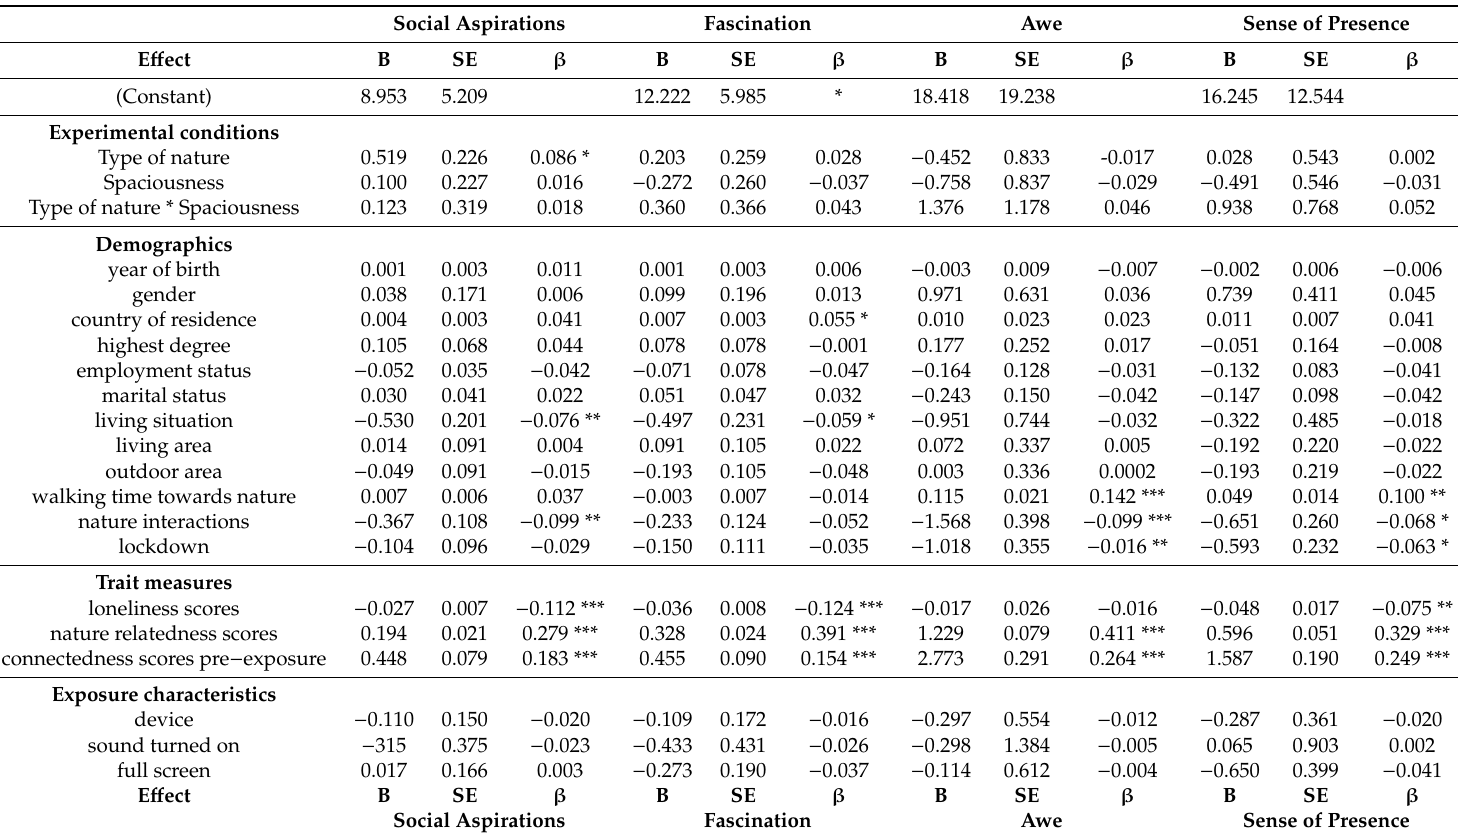
Table 2. Multiple regression models for social aspiration, fascination, awe and sense of presence (* p < 0.05, ** p < 0.01, *** p < 0.001). Social